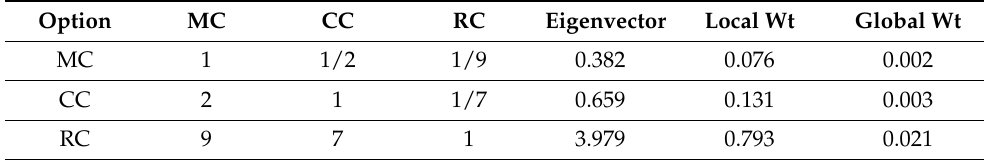
Table A10. Comparison of alternatives matrix for subcriterion SA6.